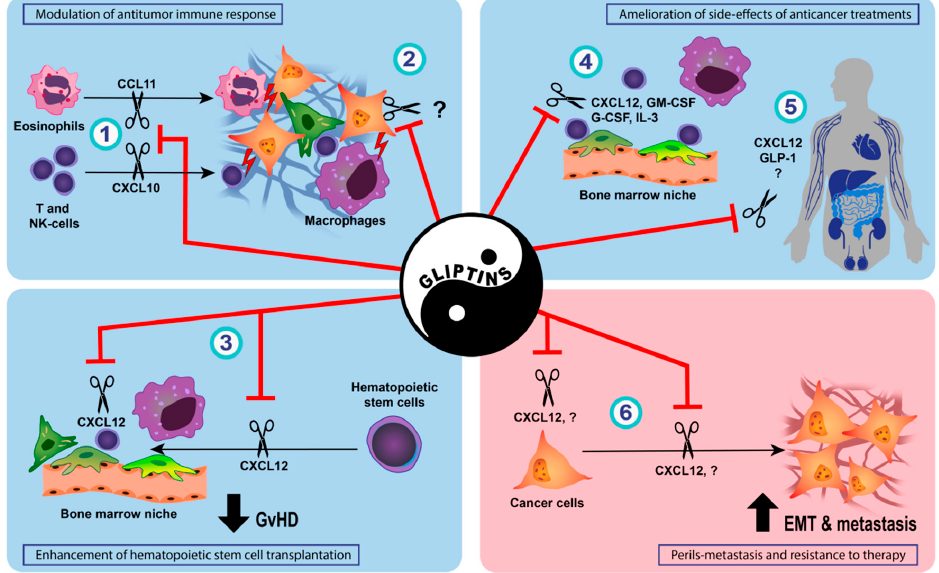
Figure 1. Potential utility and pitfalls of DPP-IV inhibition by gliptins in anticancer treatment. (1)